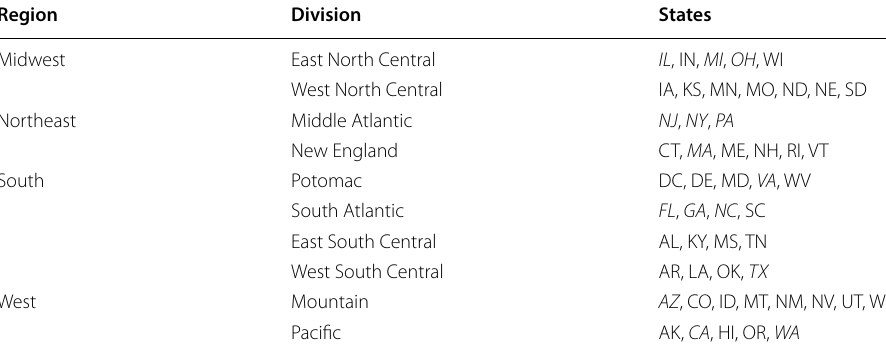
Table 3 Geography definitions Region